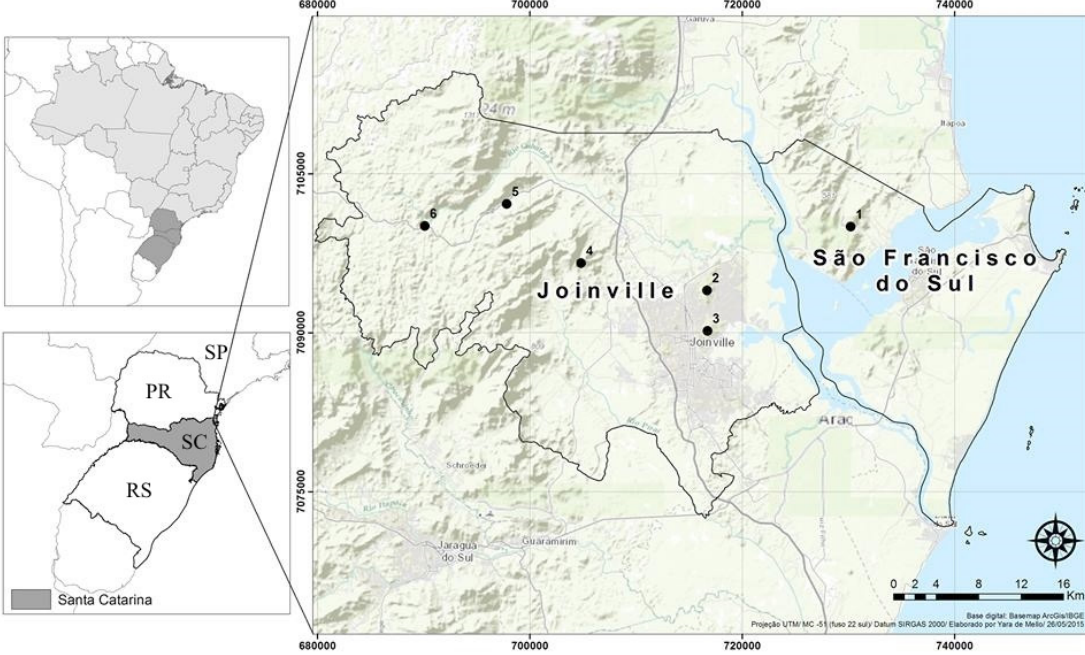
Fig 1 . Specific location of the collecting areas for Euglossini in the state of Santa Catarina. Superior left: dark gray highlight for the South region of Brazil. Inferior left: South of Brasil with dark gray highlight for the state of Santa Catarina. Right: Joinville and São Francisco do Sul counties, where the collecting occurred: 1. Vila da Gloria, 2. Morro do Finder, 3. Morro do Boa Vista, 4. Mutucas, 5. Rio Seco, 6. Castelo dos